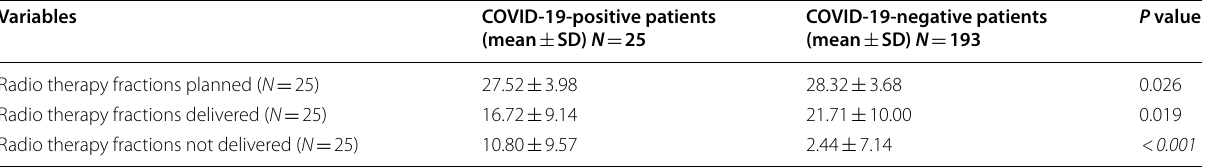
Table 4 Radiotherapy fractions planned and delivered among the radiotherapy recipients ( N